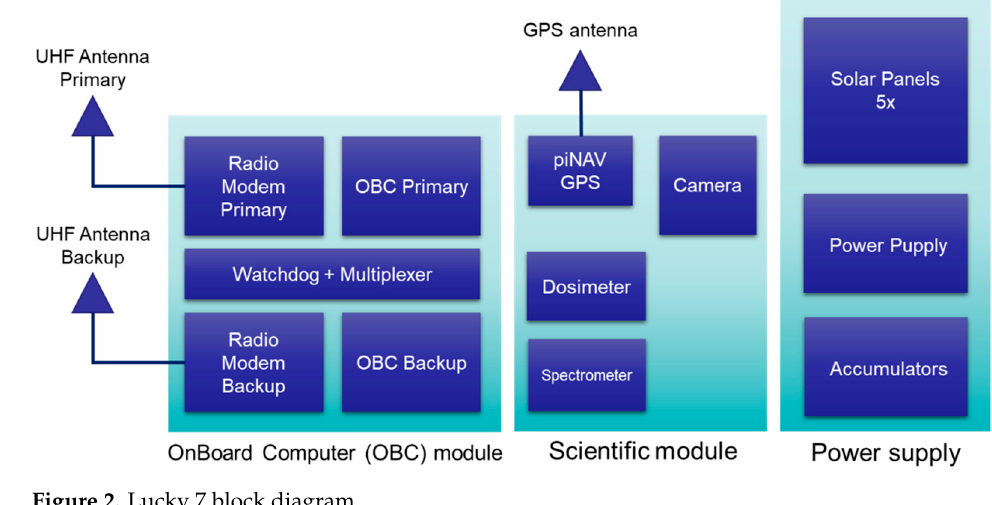
Figure 2. Lucky 7 block diagram.